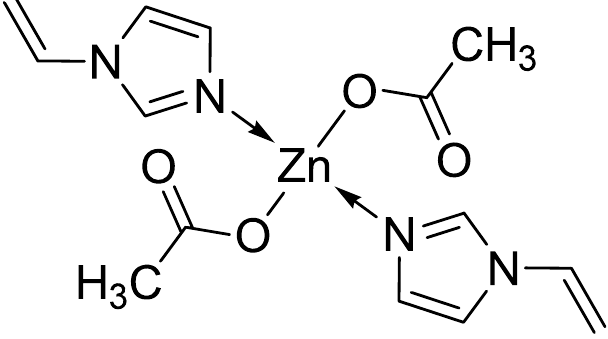
Figure 1. Structural formula of